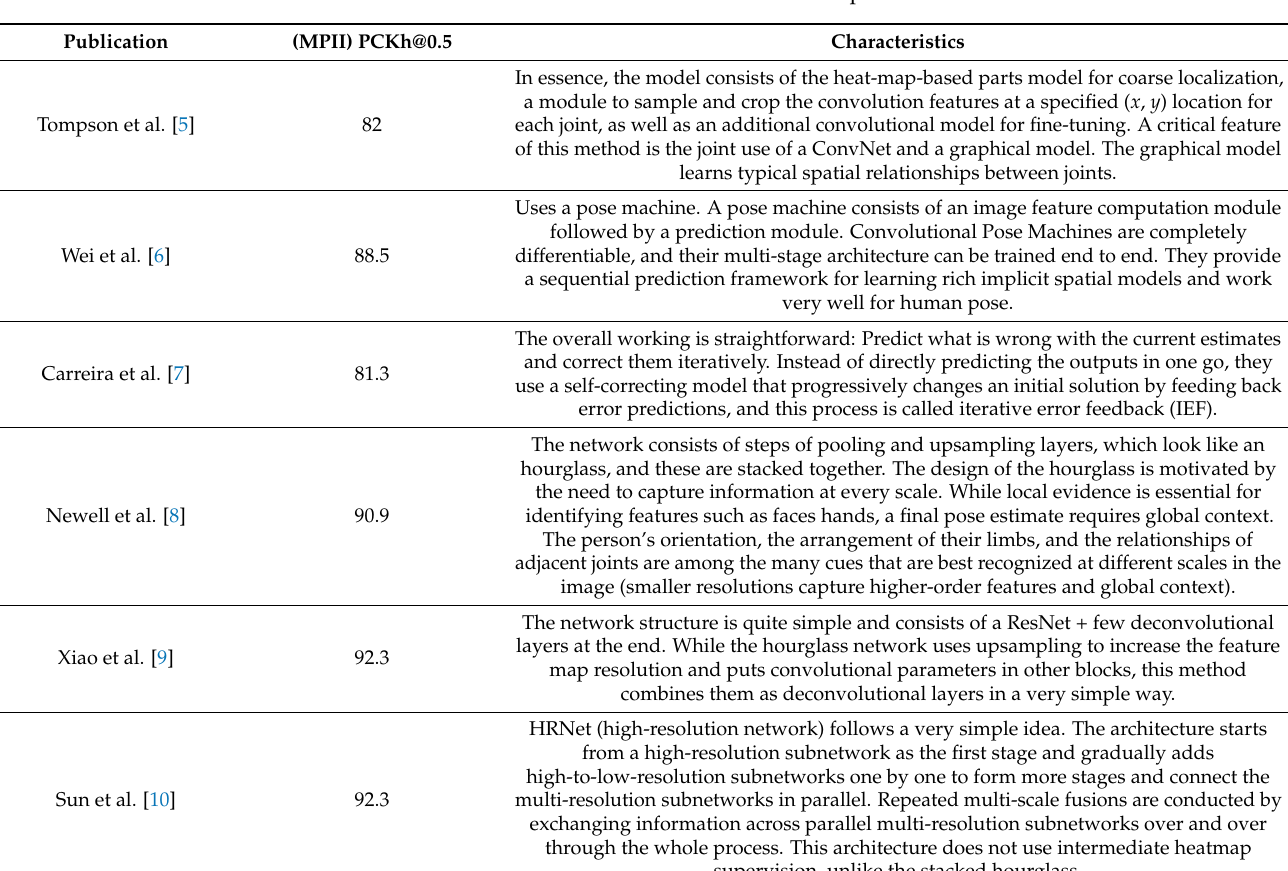
Table 1. Characteristics of the related literature on human pose